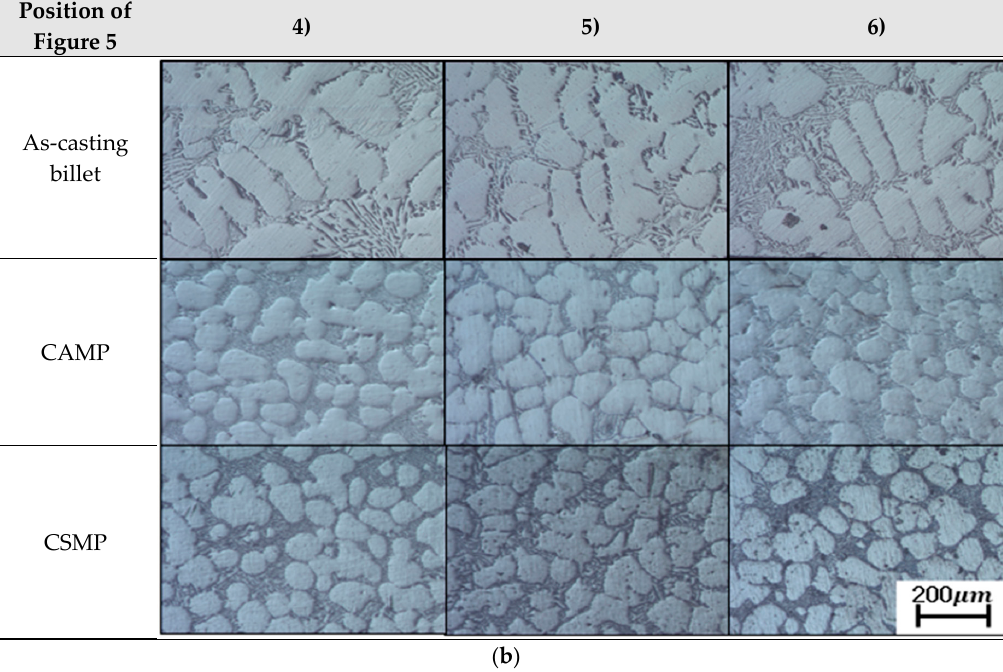
Figure 7. Microstructure of A356 100×: ( a ) measurement point of center; ( b ) measurement point of surface.